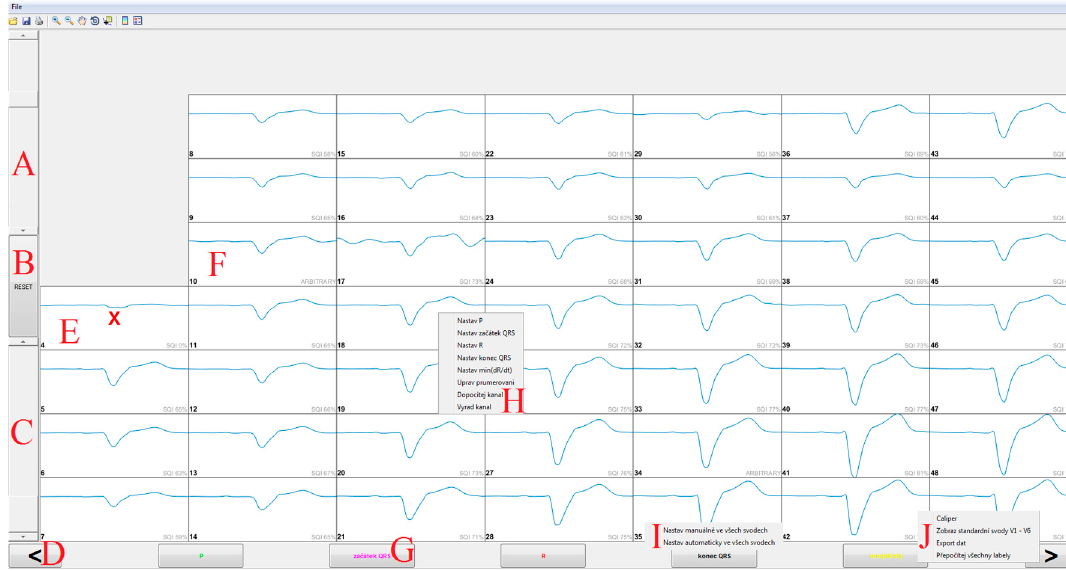
Figure 3. Example of the main window. ( A ) Settings of isoline offset; ( B ) reset into default state; ( C ) zoom over all leads; ( D ) the shift of electrodes’ straps to next one on the left side or the right side, respectively; ( E ) an excluded signal; ( F ) an arbitrary signal (calculated from signals in the neighborhood); ( G ) button for show/hide delineation (marker placed specifically on the QRS onset button); ( H ) pop-up menu for manually work with selected signal/lead—a delineation of P wave onset, QRS onset, R peak, QRS offset, and min (dR/dt); a selection of original signal’s beats for template creation; a calculation of the signal from the neighborhood; a switch for